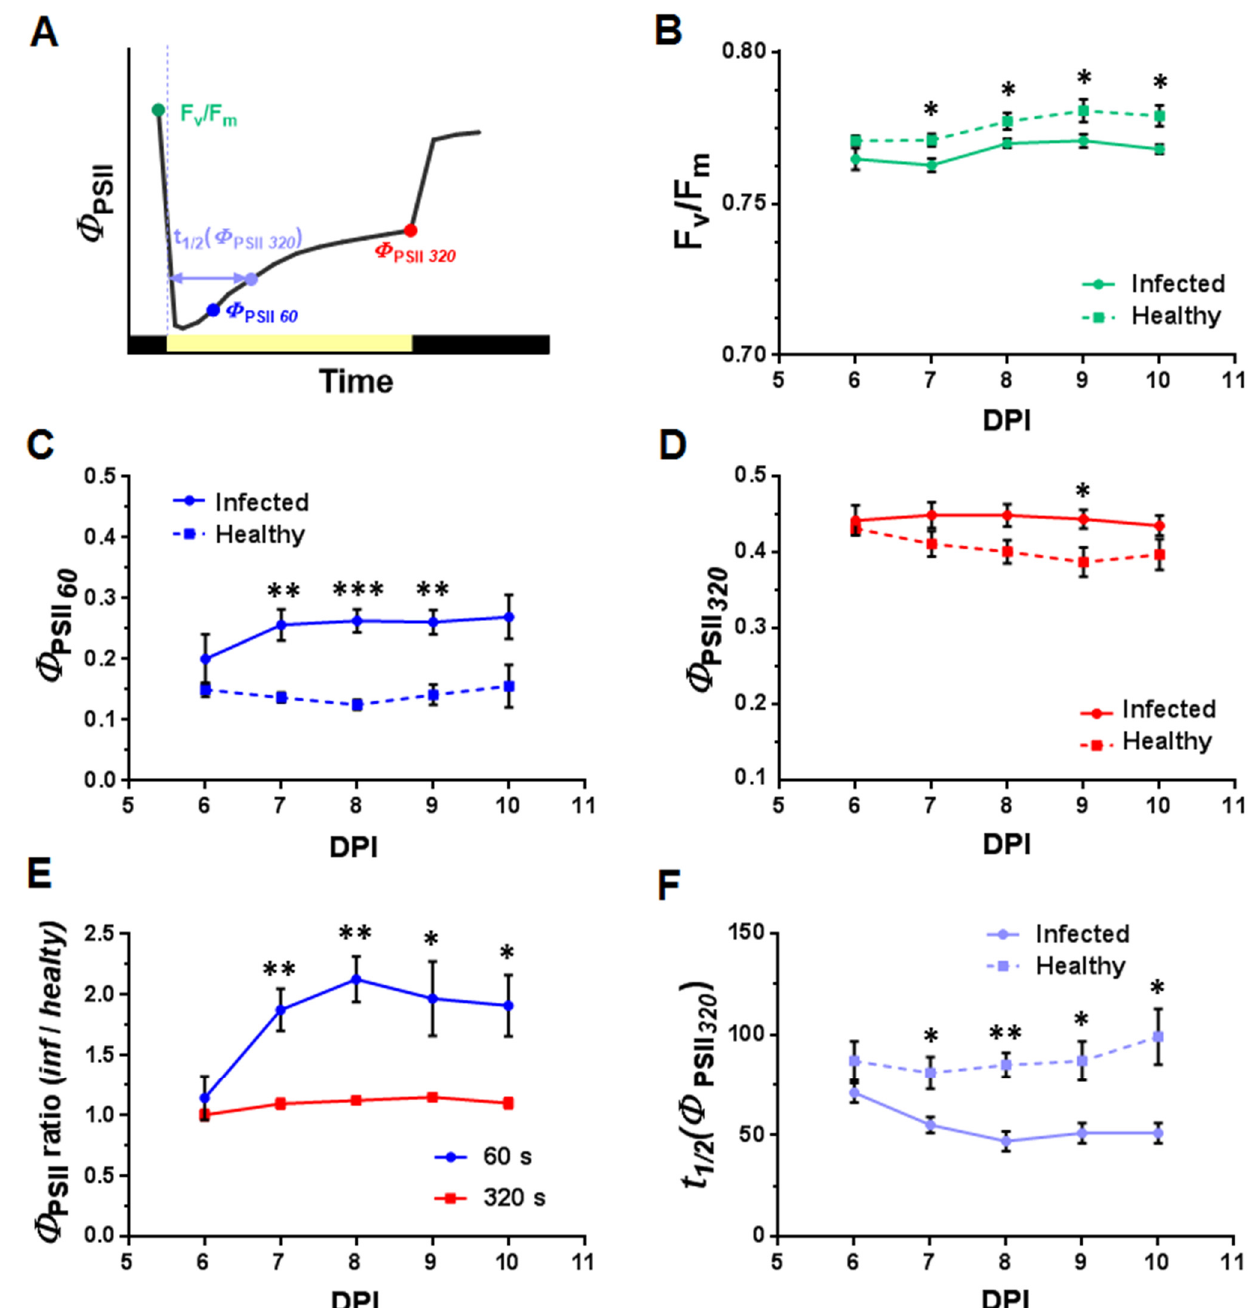
Figure 7. Dynamics of changes in the values of the characteristic parameters of the Φ PSII light curve depending on time after inoculation (DPI, day post-inoculation) ( n = 5): ( A ) A diagram showing the characteristic points of the Φ PSII light curve. ( B ) Dynamics of F v /F m . F v /F m was determined for dark adapted leaves after initial exposure of plants to a saturating light pulse. Dynamics of the quantum yield of photosystem II, determined 60 s ( Φ PSII 60 ) ( C ) and 320 s ( Φ PSII 320 ) ( D ) after the AL was switched on. ( E ) Dynamics of the Φ PSII ratio in the infected and healthy areas of the leaf. The ratios are calculated for the Φ PSII recorded 60 s (blue curve) and 320 s (red curve) after the AL was switched on. ( F ) Dynamics of the time of reaching 1/2 of the steady-state Φ PSII 320 value (t 1/2 ( Φ PSII 320 )); 6 DPI corresponds to the first day of PVX-GFP detection in the studied leaf. Values are mean ± SEM. *, **, *** indicate statistically significant differences between the values in the infected and healthy areas or the differences in the ratios from 1 ( p < 0.05, 0.01 and 0.001, respectively).